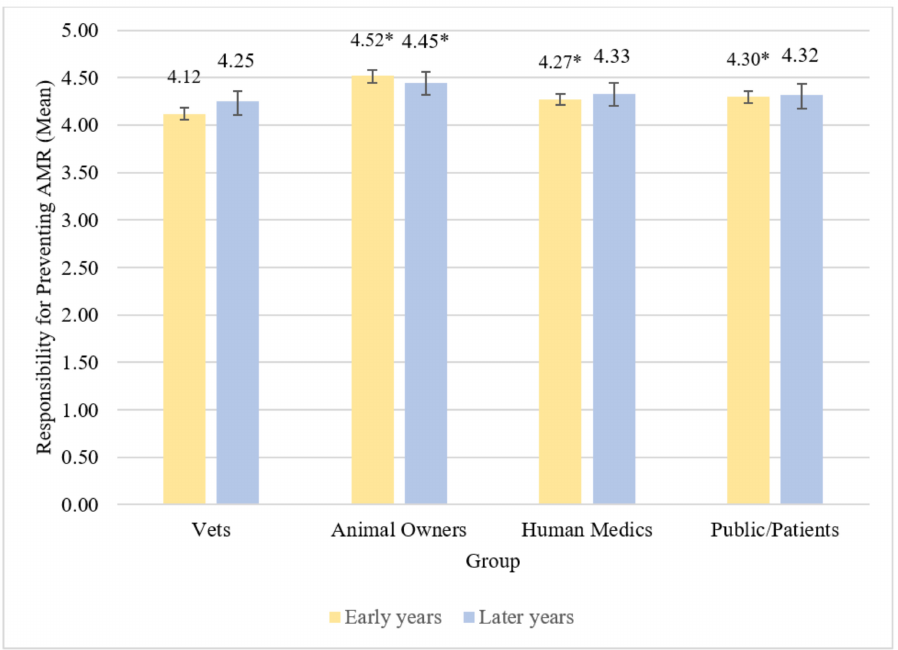
Figure 3. Mean beliefs about responsibility for preventing ABR by group among early and later years students. Vets designated as reference group. * denotes difference from reference group at p < 0.001. Error bars represent 95% bias-corrected and accelerated bootstrap confidence